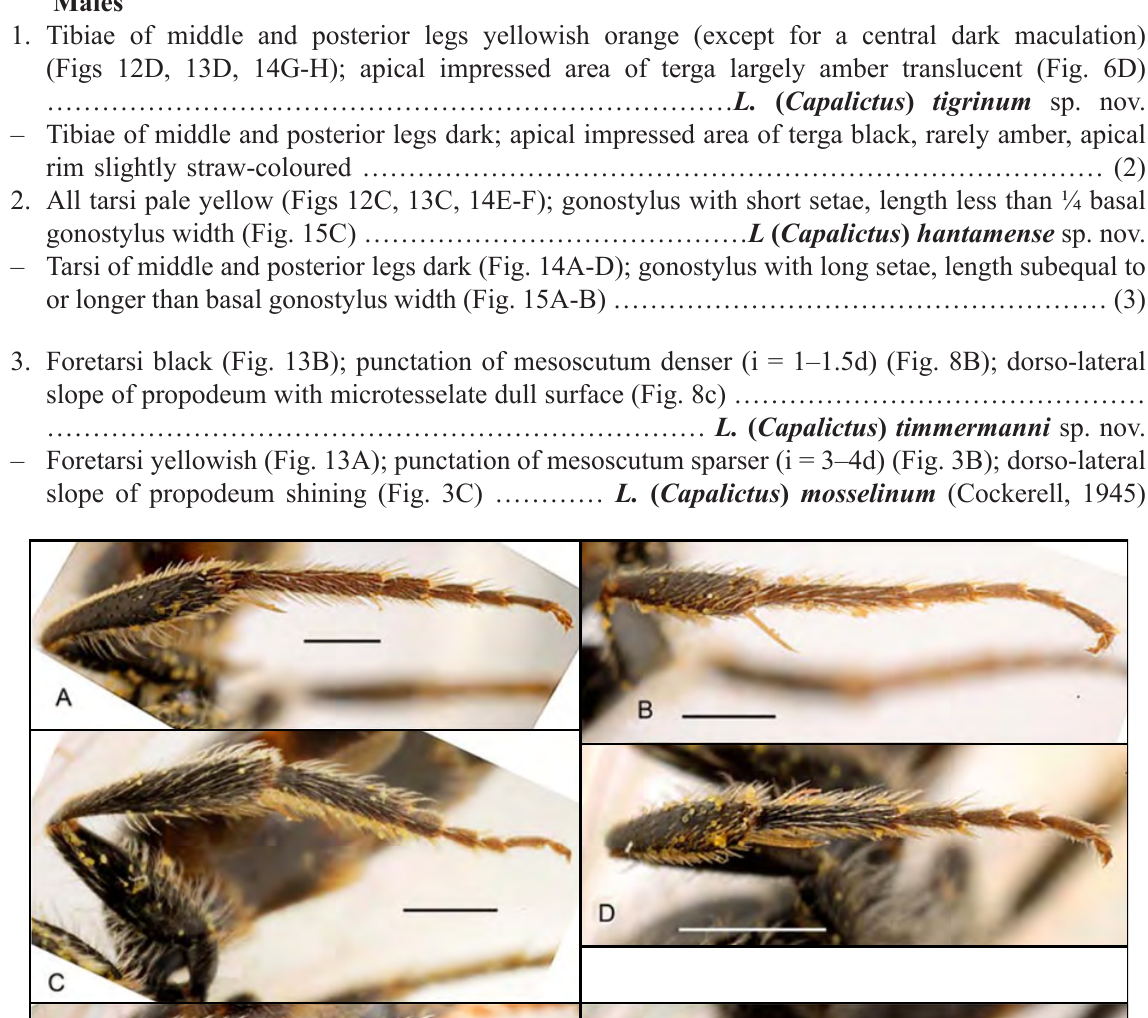
Key to species Males 1. Tibiae of middle and posterior legs yellowish orange (except for a central dark maculation) (Figs 12D, 13D, 14G-H); apical impressed area of terga largely amber translucent (Fig. 6D) – Tibiae of middle and posterior legs dark; apical impressed area of terga black, rarely amber, apical 2. All tarsi pale yellow (Figs 12C, 13C, 14E-F); gonostylus with short setae, length less than ¼ basal – Tarsi of middle and posterior legs dark (Fig. 14A-D); gonostylus with long setae, length subequal to 3. Foretarsi black (Fig. 13B); punctation of mesoscutum denser (i = 1–1.5d) (Fig. 8B); dorso-lateral